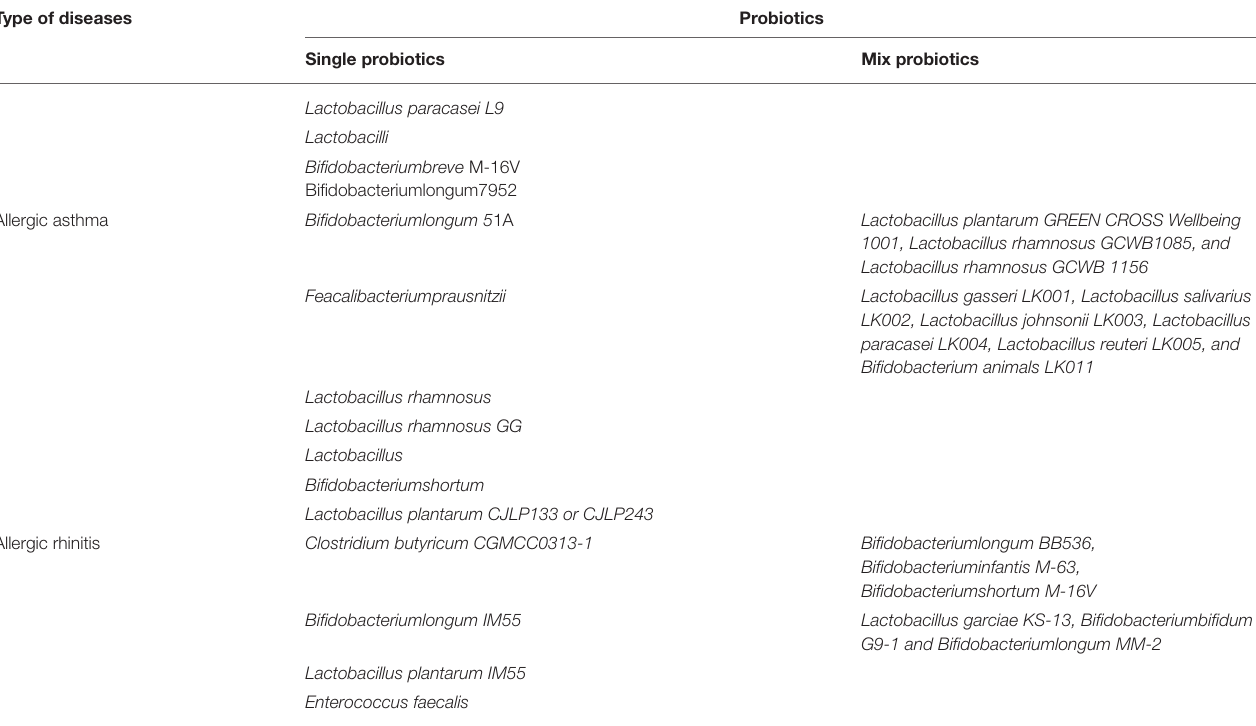
TABLE 2 | Probiotics use in allergic asthma and allergic rhinitis. Type of